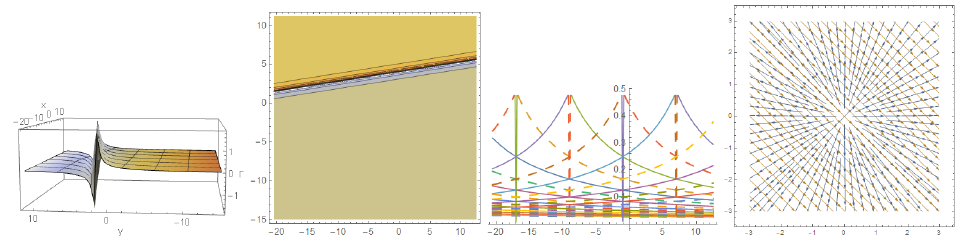
Figure 2. MSR graphic profiles for Γ 1 ( x , y , t ) with t = 9.